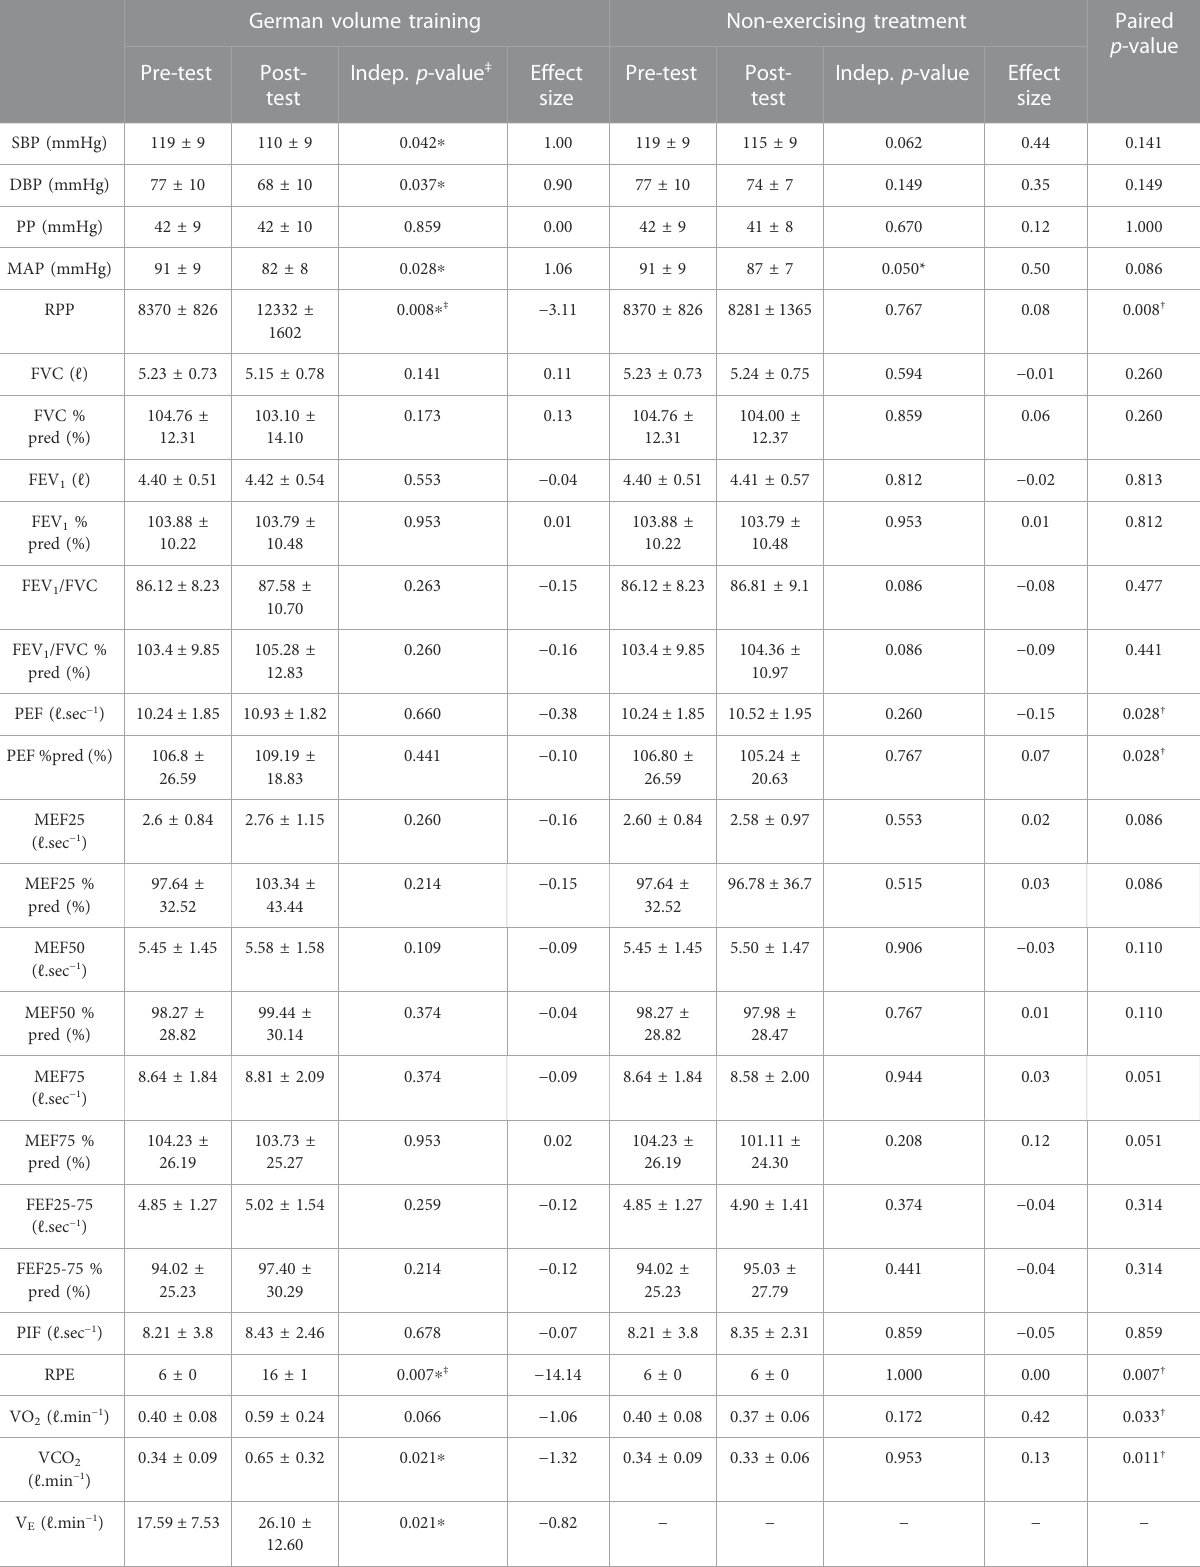
TABLE 2 Acute vasopressor, pulmonary and metabolic responses to a single-session of German Volume Training